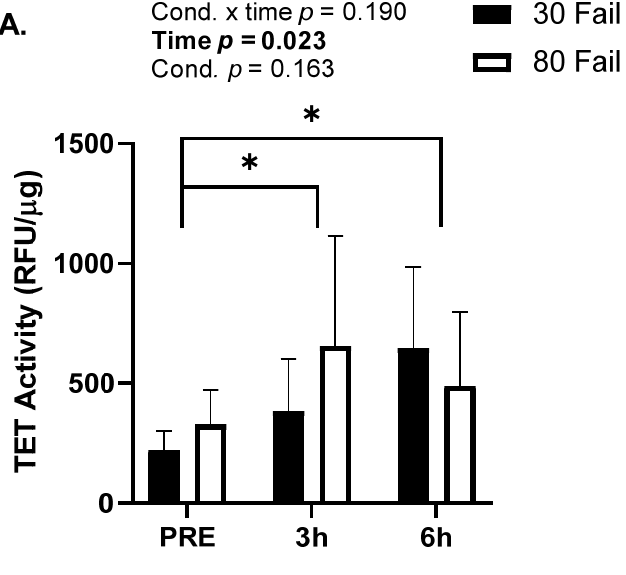
Figure 4. Nuclear TET and DNMT activities between bouts. All data are presented as mean ± SD for global TET activity ( n = 10) from PRE to 3 h POST and 6 h POST resistance exercise (panel A ) and DNMT activity ( n = 9) from PRE to 3 h POST and 6 h POST resistance exercise (panel B ); Symbol: *, indicates a significant change from PRE regardless of bout. Abbreviations: 30 Fail, 30% one repetition maximum to failure bout; 80 Fail, 80% one repetition maximum to failure bout; DNMT, DNA Methyltransferase; OD, optical density; RFU, relative fluorescent units; TET, Ten-Eleven Trans- locase.